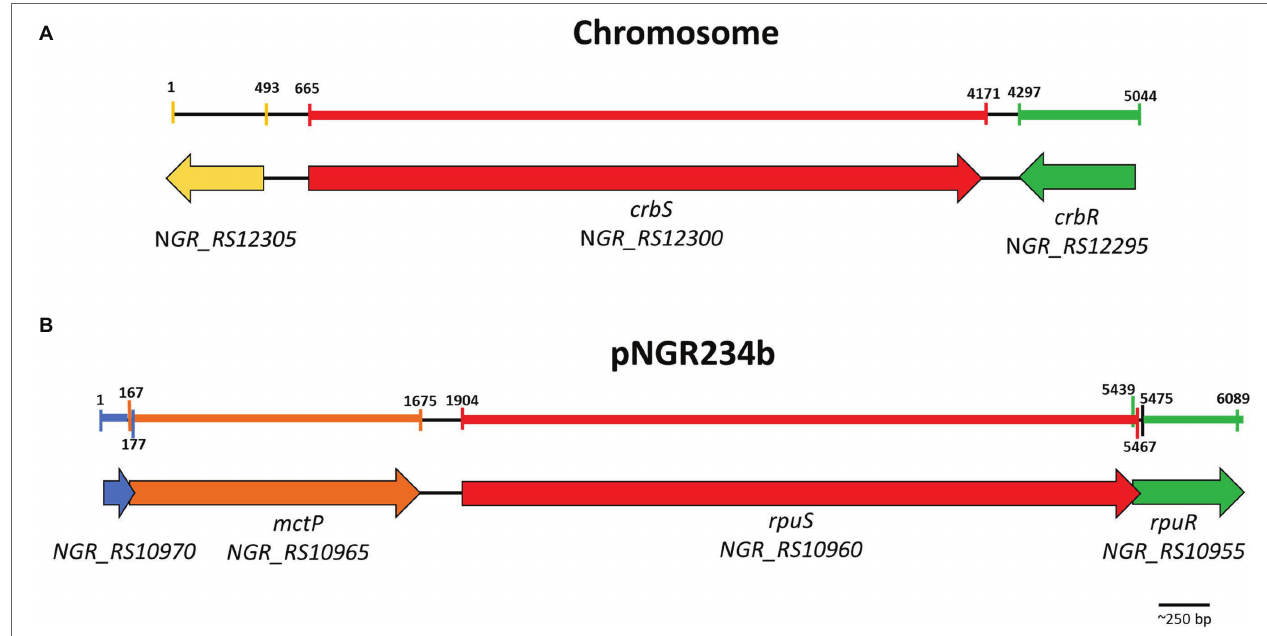
FIGURE 1 | Genomic context of the CrbS/R and RpuS/R TCSTS. Genes are annotated as follows Red, SLC5/STAC Histidine kinase; Green, LuxR family response regulator; Orange, monocarboxylate permease; Blue, DUF3311 domain-containing protein; Yellow, Large-conductance mechanosensitive channels mscL family. Colored areas in the scale bars indicate the region deleted for the construction of the mutant strain in the corresponding